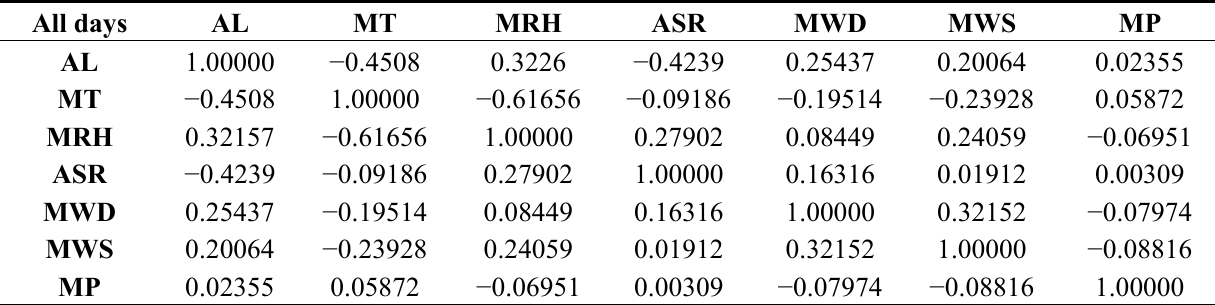
Table 1. Correlation between climate variables and aggregated load. Aggregated Load ( AL ); Mean Temperature ( MT ); Mean Relative Humidity ( MRH ); Aggregated Precipitation ( AP ); Aggregated Solar Radiation ( ASR ); Mean Wind Direction ( MWD ); Mean Wind Speed ( MWS ); and Mean Pressure ( MP